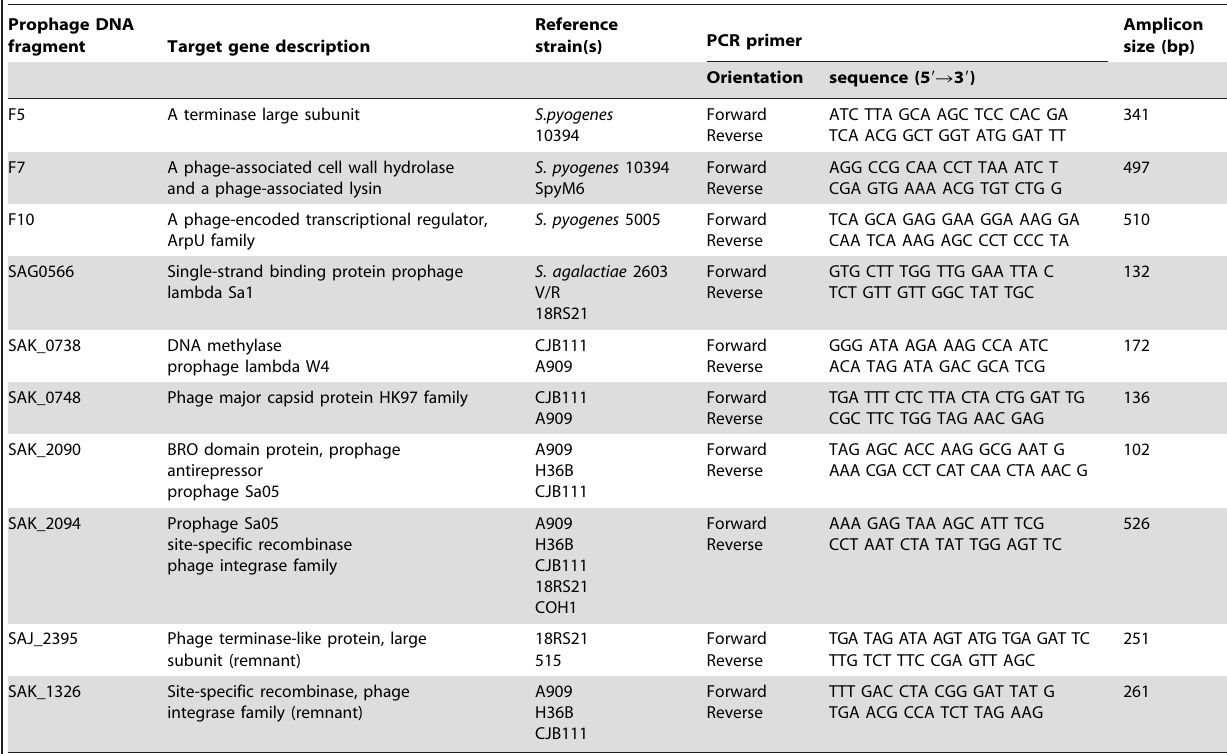
Table 1. PCR primers and amplicon sizes for prophage screening.